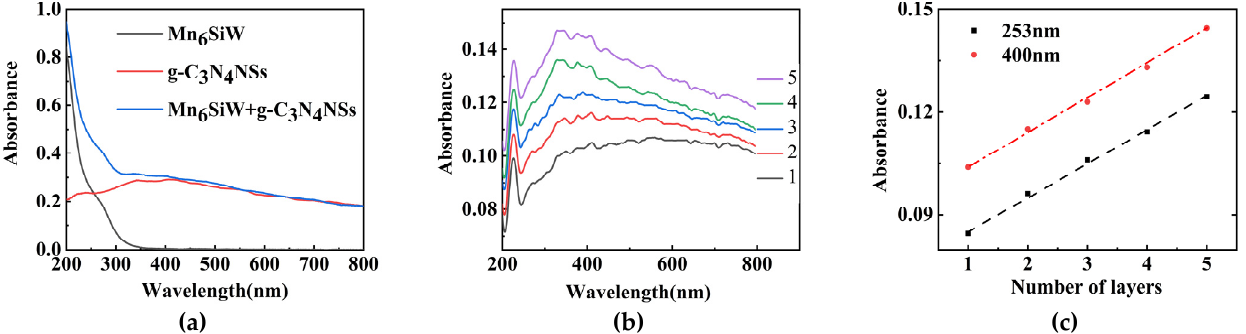
Figure 5. ( a ) UV-vis absorption spectra of g-C 3 N 4 NSs (0.6 mM), Mn 6 SiW (5 μ M) and g-C 3 N 4 NSs-Mn 6 SiW (0.6 mM: 3 μ M) mixture in the aqueous solutions; ( b ) UV-vis spectra for the [g-C 3 N 4 NSs/Mn 6 SiW]n film on quartz slide; ( c ) relationship of the absorbance value and layer number at λ = 253 nm and λ = 400 nm.